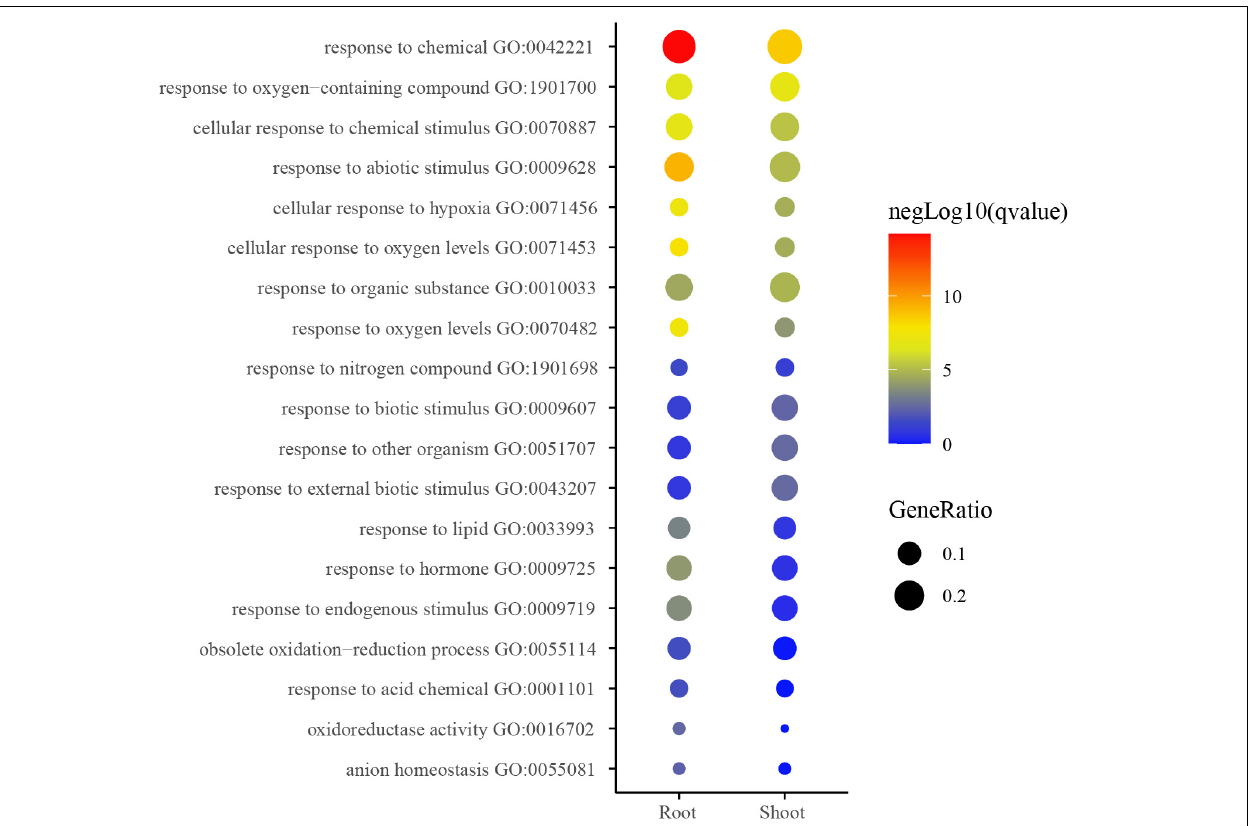
FIGURE 5 | GO analysis of low K-responsive modules in root and shoot. The heatmap scale reflects the significant level of enrichment of GO terms; the red showed the most significant enrichment in statistics. Size of spot represents transcript numbers of